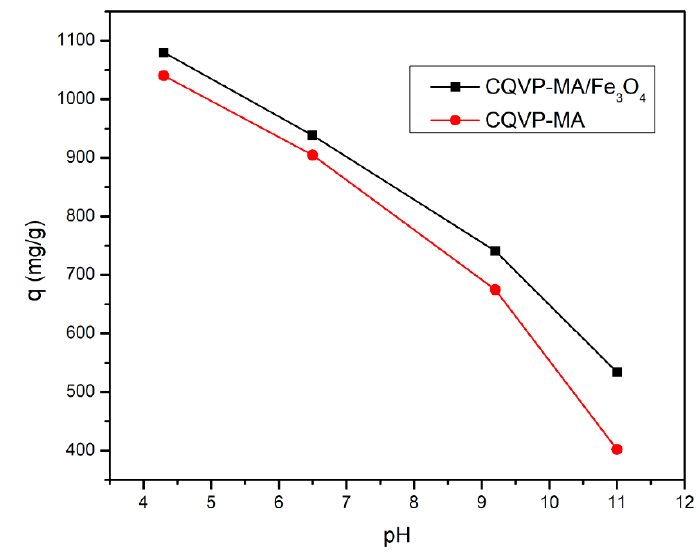
Figure 8. Adsorption capacity of CQVP/MA and CQVP/MA-Fe 3 O 4 for CBB in its aqueous solution with different pH at room temperature.